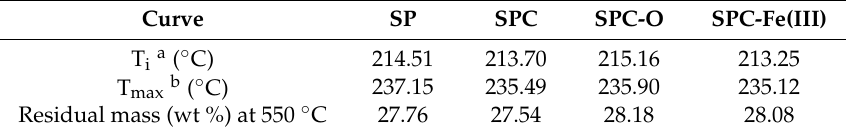
Table 3. Thermo-degradation data of control and soy-based composite film samples.